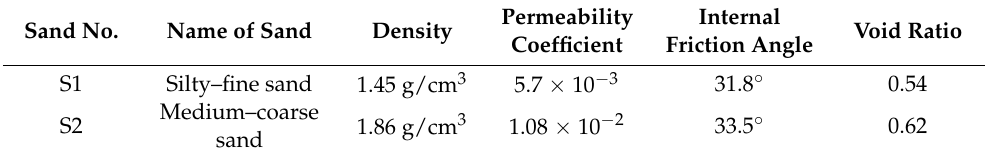
Table 2. Basic properties of the